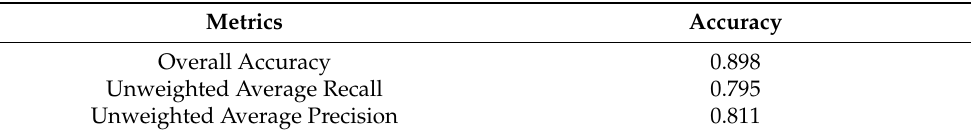
Table 5. Results of emotion classification by Russian experts in acting emotional speech of Russian Table 5. Overall scores in multi-class classification, expert’s feature set with 16 samples in total. children.